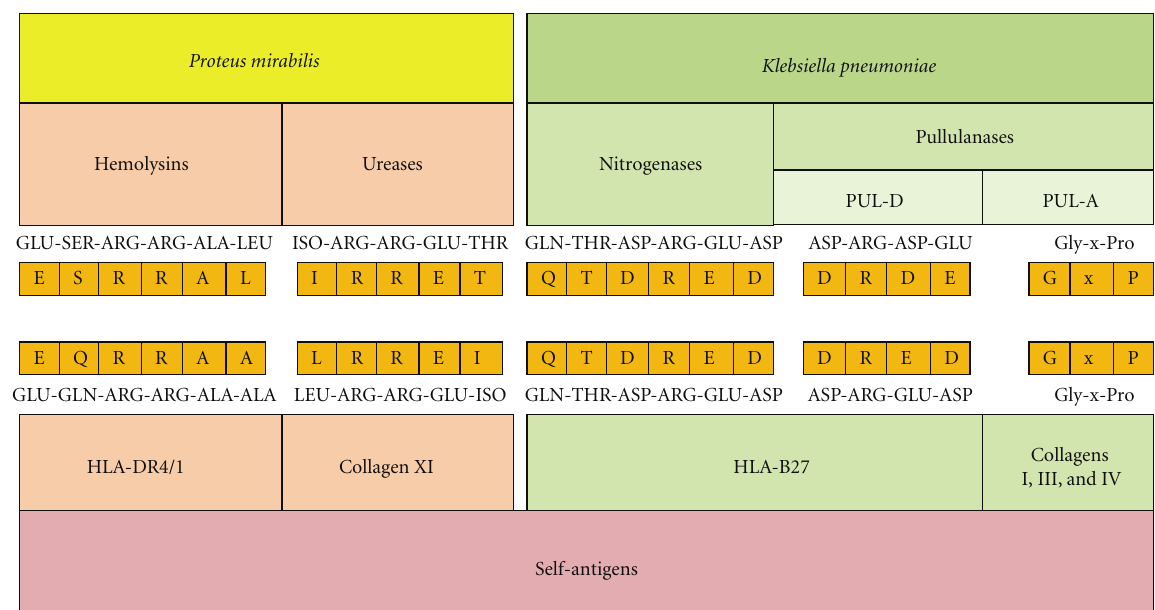
Figure 1: Schematic representation of the molecular similarities between bacterial, Klebsiella or Proteus, and self-antigens.